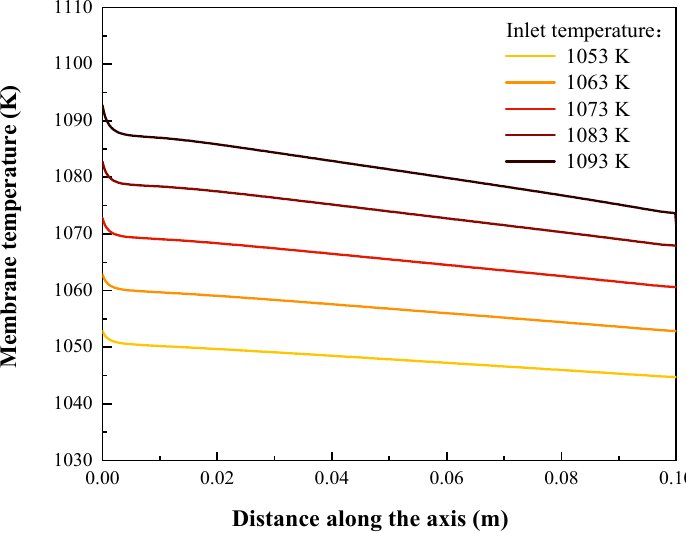
Figure 13. Effect of inlet temperature on membrane temperature.